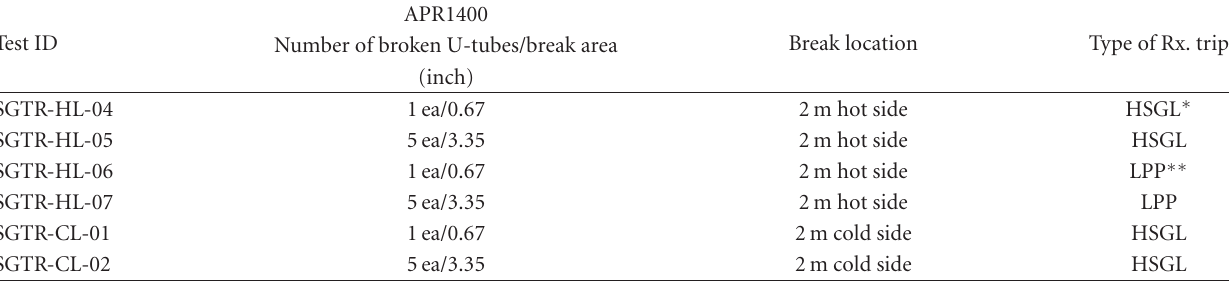
Table 5: Test matrix for SGTR tests.